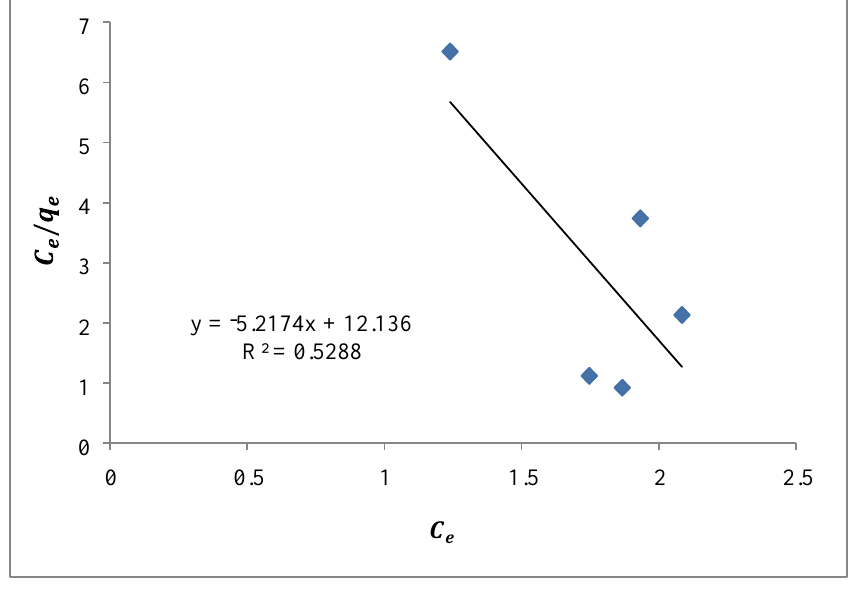
Figure 3. Langmuir isotherm for sawdust